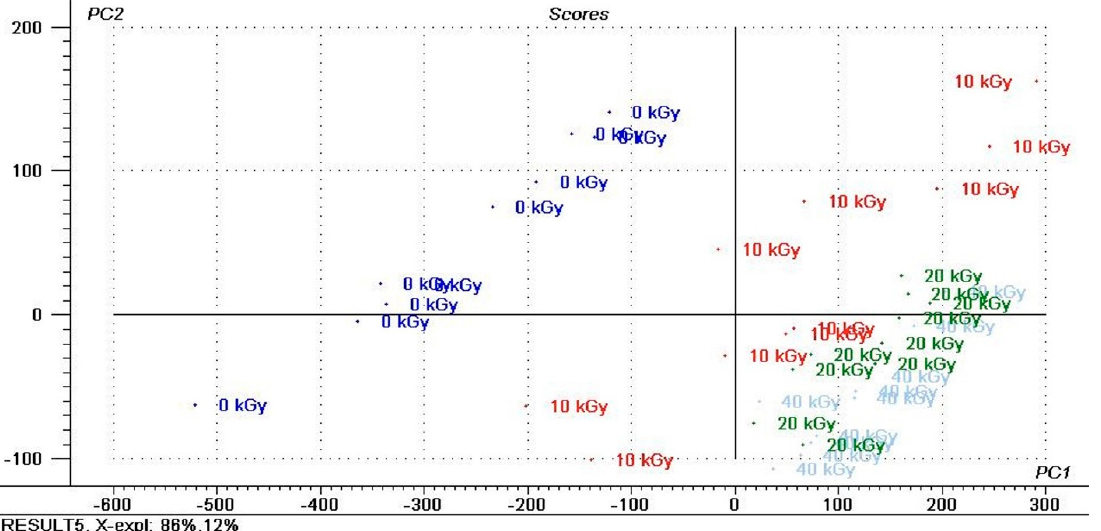
Figure 7. PCA results of IR spectra of the AA-S film and score plot for two significant principal components, PC1 vs. PC2 (non-irradiated (0 kGy) and irradiated with different doses (10, 20 and 40 kGy)).